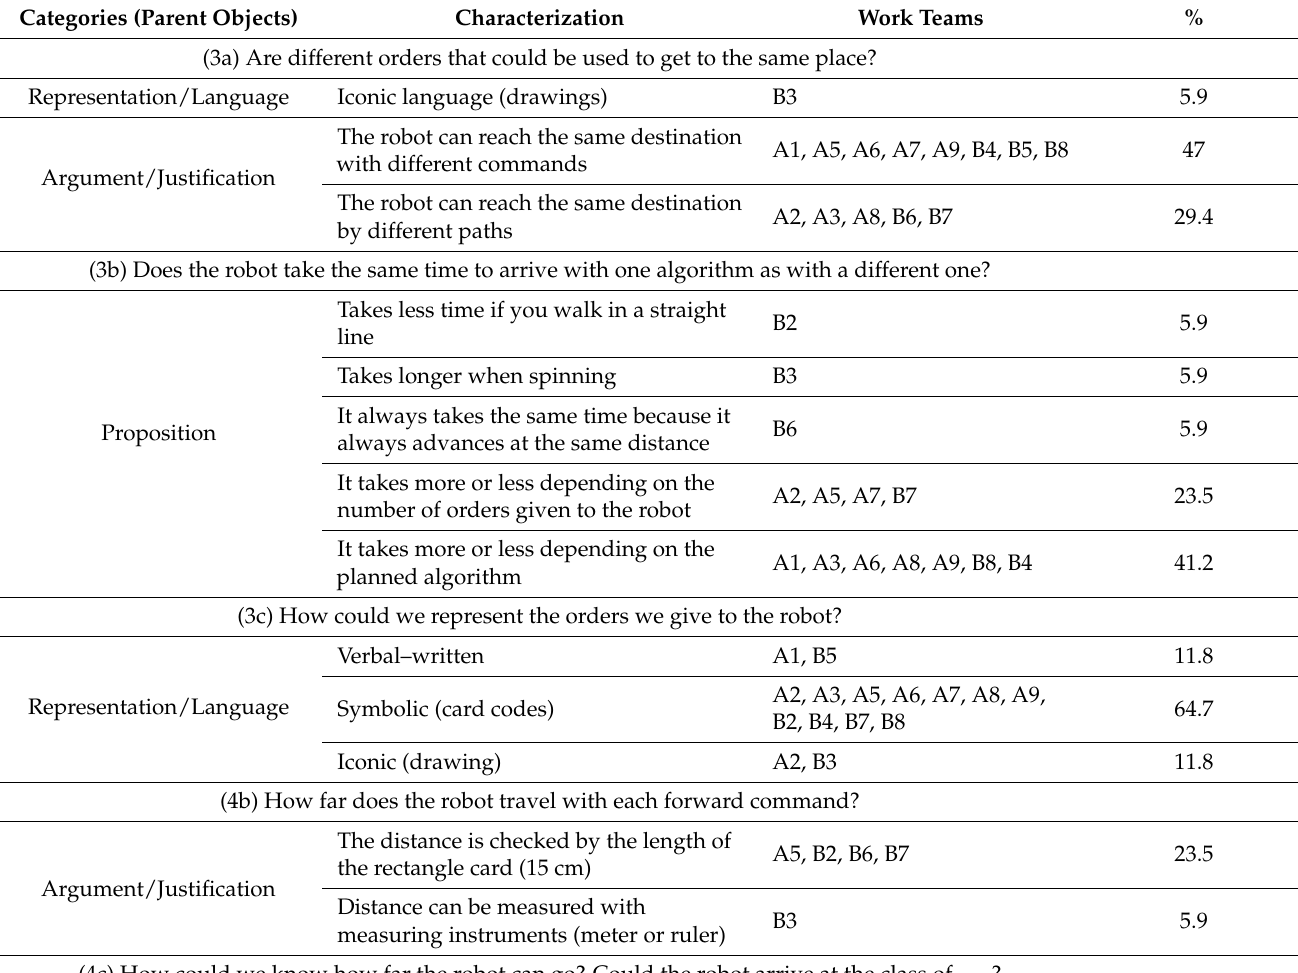
Table 4. Emerging primary objects in solving robotics